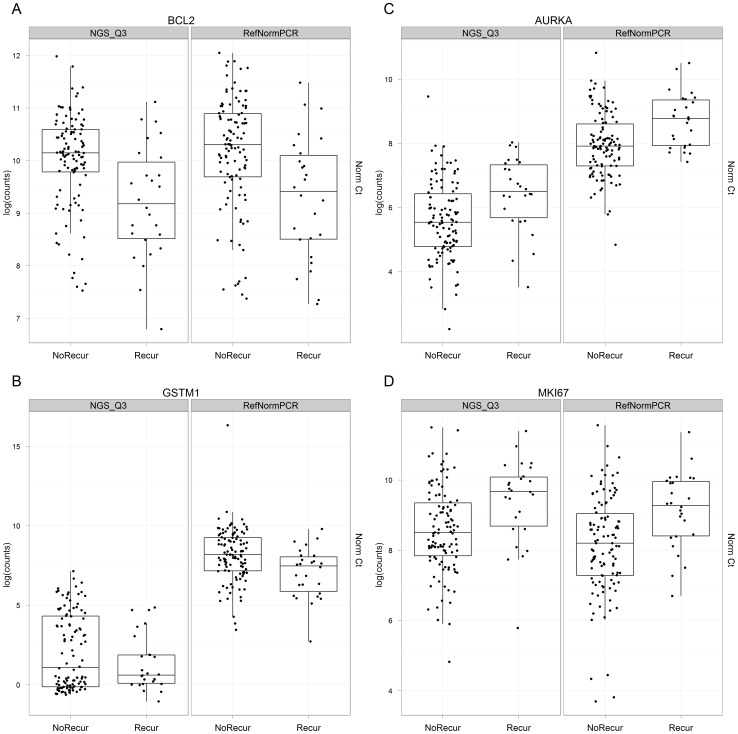
Box plots of normalized expression values of RNAs in breast cancer patients, stratified by recurrence status.Each point represents a patient tumor. The bottom and top of the box are the 25th and 75th percentiles and the band within the box is the 50th percentile (the median) of the points in the group. The ends of the vertical lines represent the lowest datum still within 1.5 interquartile range of the lower quartile, and the highest datum still within 1.5 interquartile range of the upper quartile. Values from RNA-Seq (left panel) and RT-PCR (right panel) are shown: A. BCL2. B. GSTM1. C. AURKA. D. MKI67.